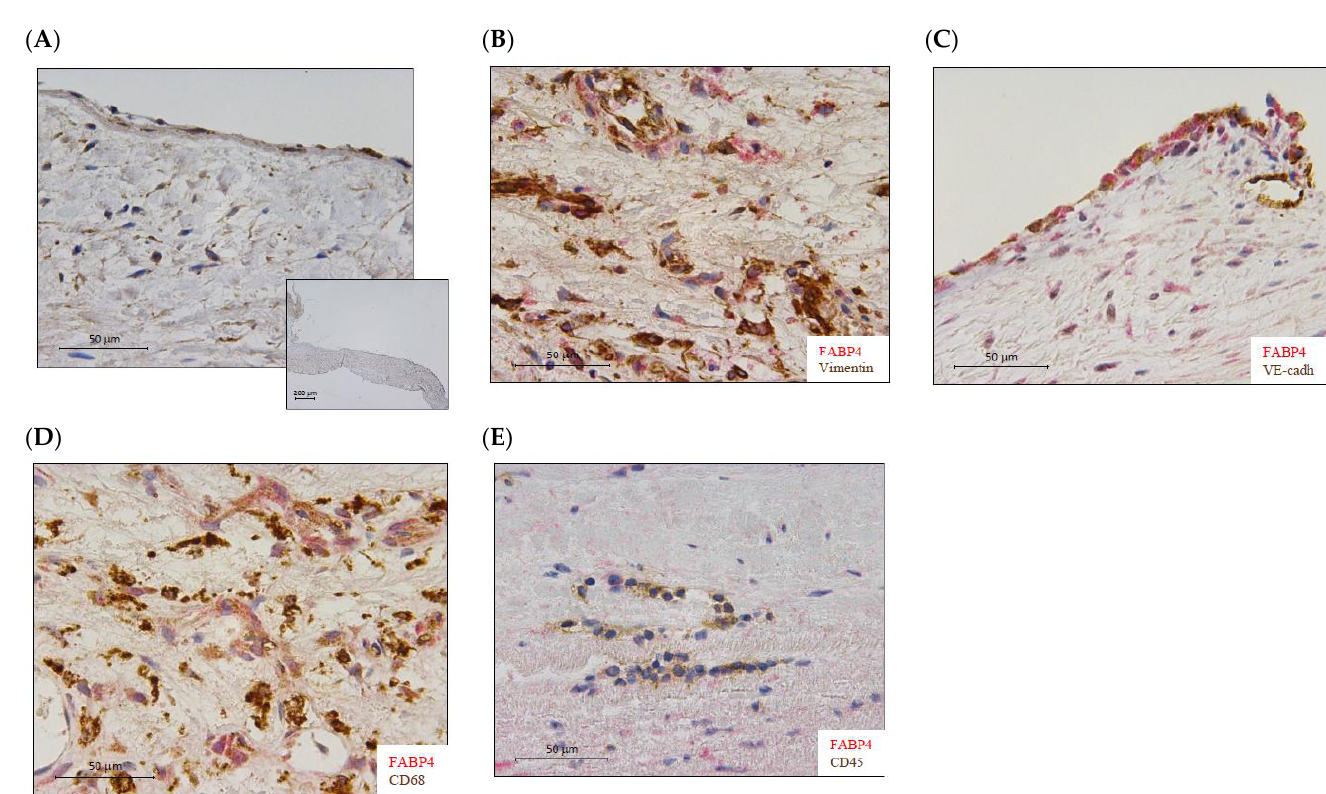
Figure 1. The expression of FABP4 in human aortic valves. ( A ) Representative microphotographs of AV sections immunostained for FABP4 in the control AVs. ( B ) Co-localization of FABP4 (in red) with Vimentin, ( C ) VE-Cadherin, and ( D ) CD68 but not with CD45 ( E ) positive cells (in brown) in AVs from AS patients. AV: aortic valve; AS: aortic stenosis; FABP4: fatty acid-binding protein 4; VE-cadherin, vascular endothelial cadherin; CD, cluster differentiation.